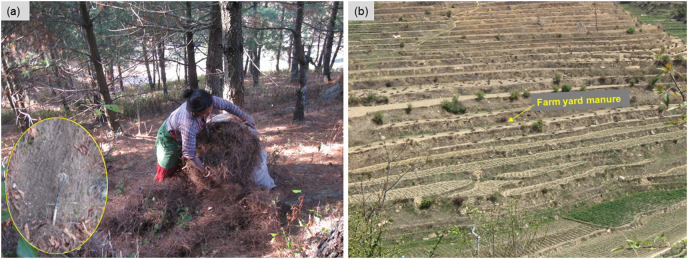
Surface disturbance (inset) due to litter collection using a hand hoe in the (a) community forest and application of forest litter-based farmyard manure on the (b) agricultural terraces in the Kharka catchment.